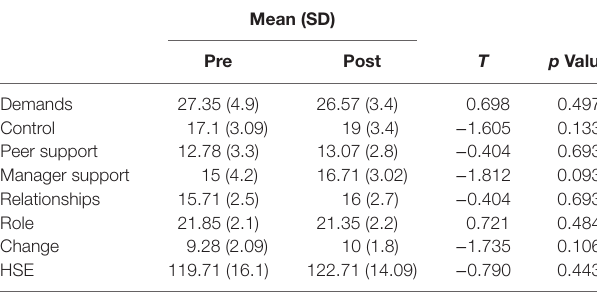
TaBle 4 | Comparison of total and subscale HSE scores in baseline and final sessions.